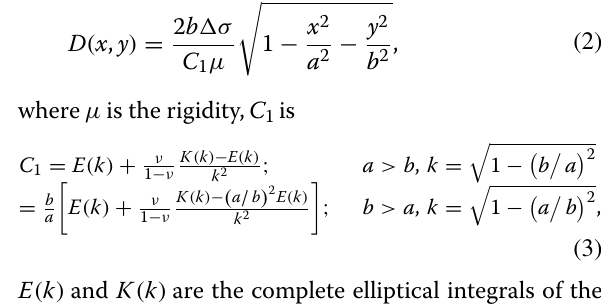
Figure S2 : Dynamic rupture propagation in the case with the free surface when is 100 MPa, is 50 MPa (case A), is 0.1 m, and is 0.8. Figure S3 : Final slip distribution in cases C, D, and G. Figure S4 : Observed and synthetic near-fault ground displacements at KMMH16 (KiK-net), 93048, and 93049 (deployed by the local government of Kumamoto prefecture) stations. Figure S5 : Assumed slip distribution of the aseismic slip, ΔCFS due to the aseismic slip, and ΔCFS due to the combination of the aseismic slip and the foreshocks. Figure S6 : Dynamic rupture propagation in case A2 with the free surface. The stress changes due to the aseismic slip and the foreshocks were taken into account in this